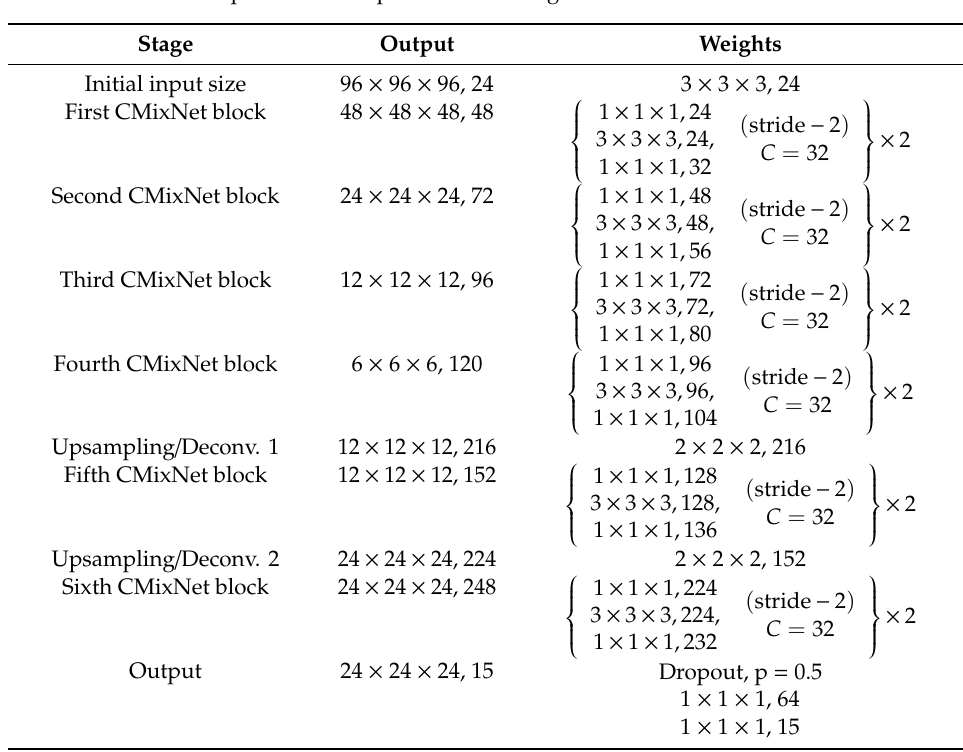
Table 3. Output feature maps at di ff erent stages of our CMixNet